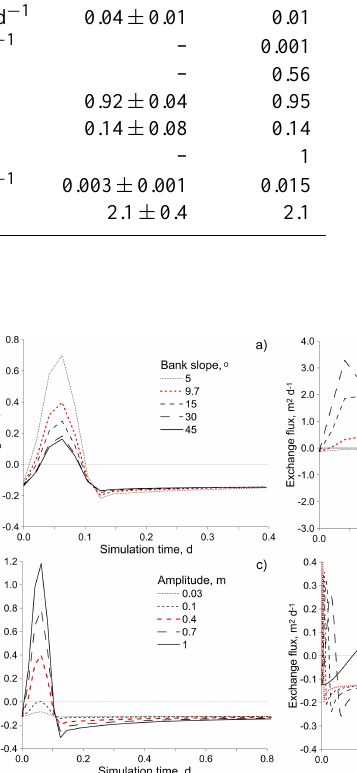
flux across the river–aquifer interface (Fig. 6c). There